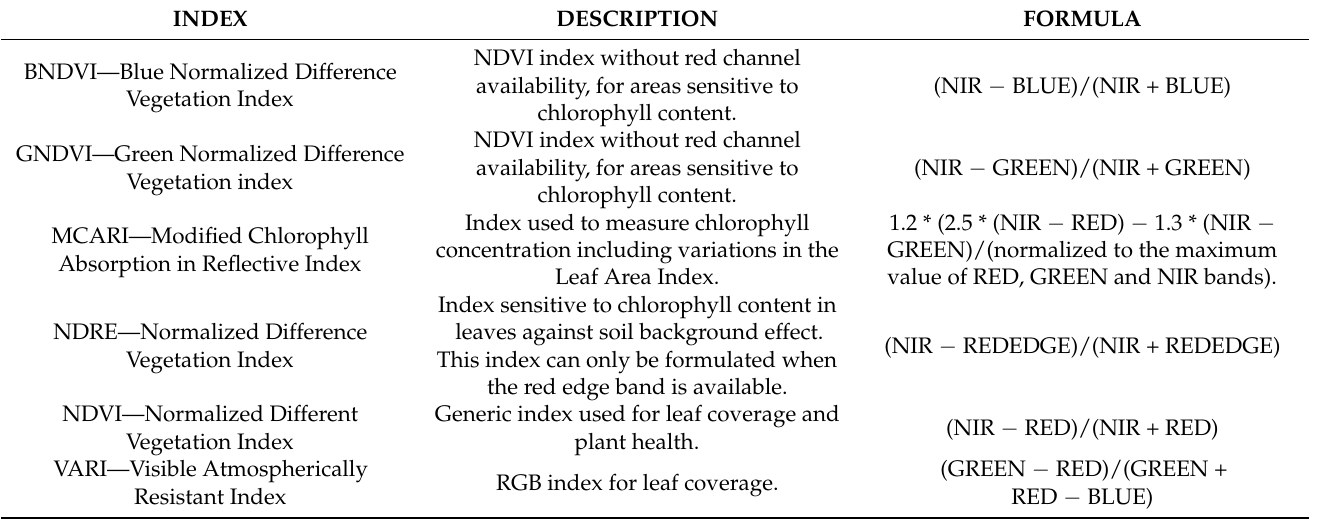
Table 1. Vegetation Indices calculated from UAV-based Multispectral camera referred from